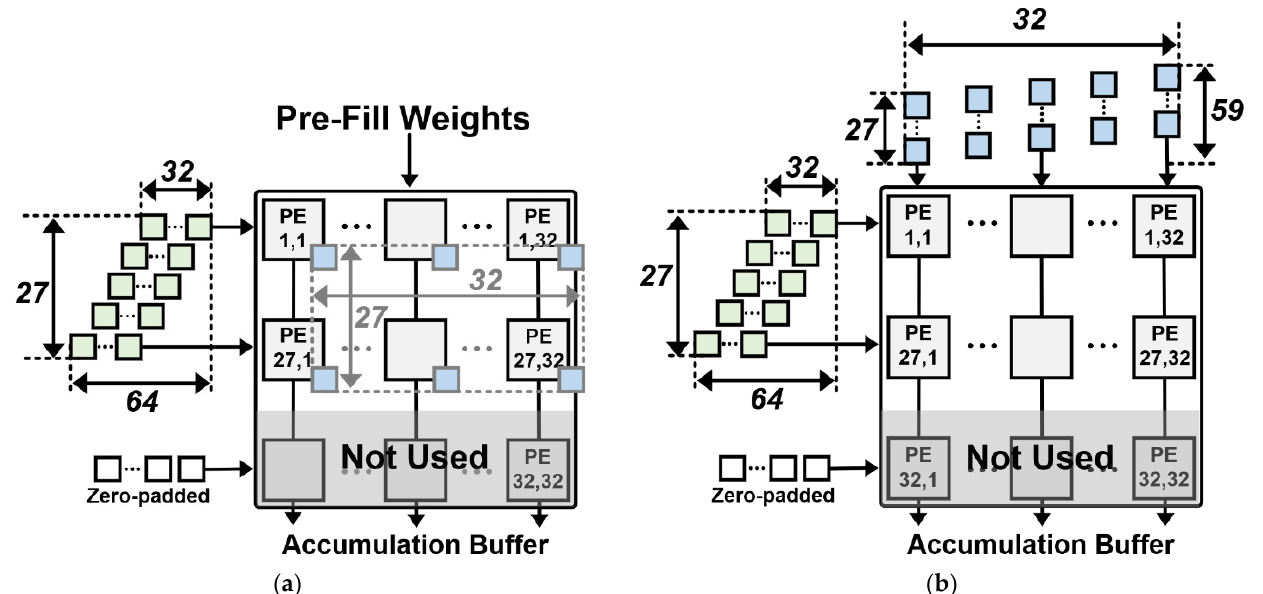
Figure 5. Matrix multiplication of conv1 layer in 32 × 32 systolic array: ( a ) Weight Stationary (WS) and ( b ) Output Stationary (OS).